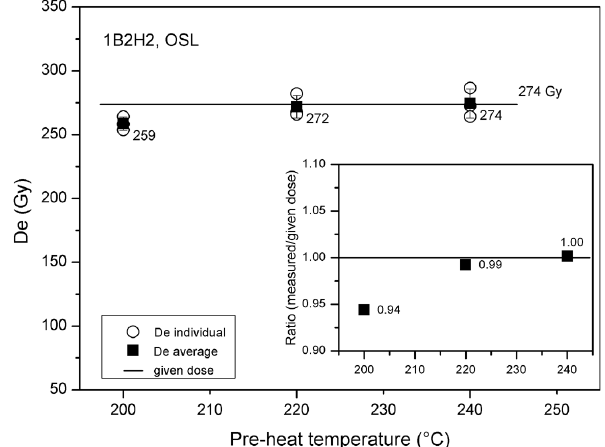
Fig. 3a. Validation of protocol parameters. A pre-heat plateau test at sample 1B2H2, carried out to define the appropriate pre-heat tem- perature. Three sub-samples of fine grain quartz were measured per temperature step and the resulting D e plotted against the tempera- ture. A 240/220 ◦ C pre-heat/cut heat was chosen for further experi- ments with the SAR protocol.